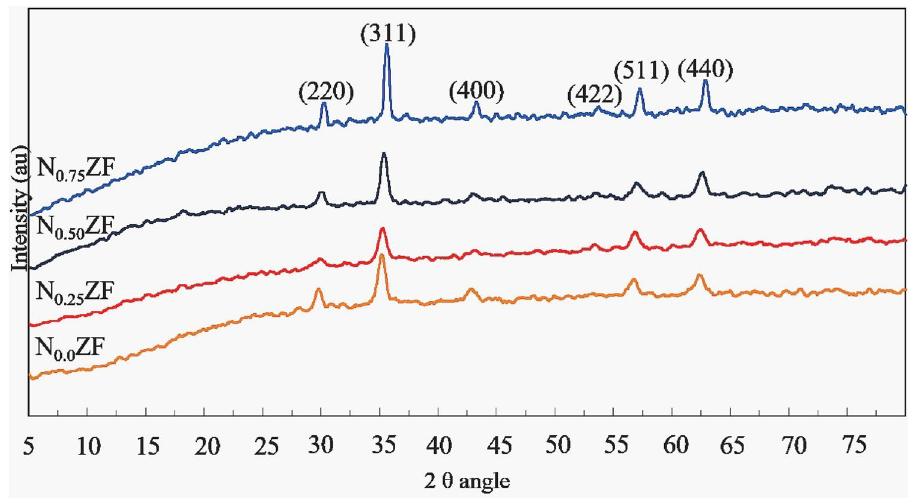
Figure 5. XRD patterns for the prepared NZF samples with different Ni